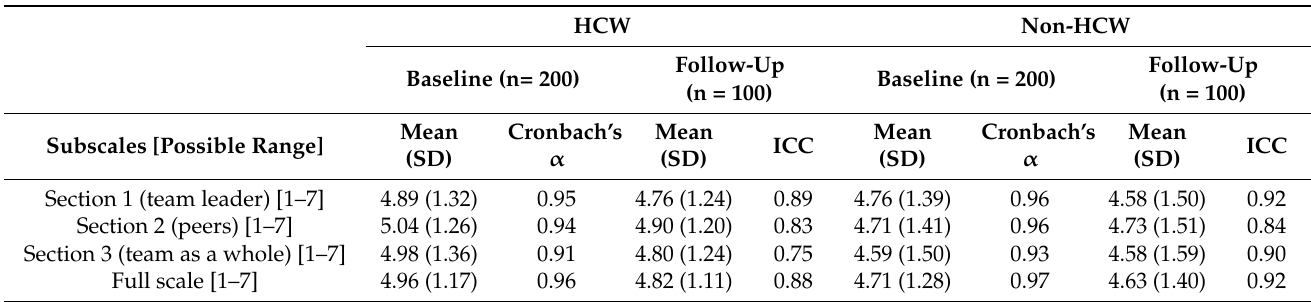
Table 2. The mean scores of the survey measures of psychological safety and internal and test– retest reliability.